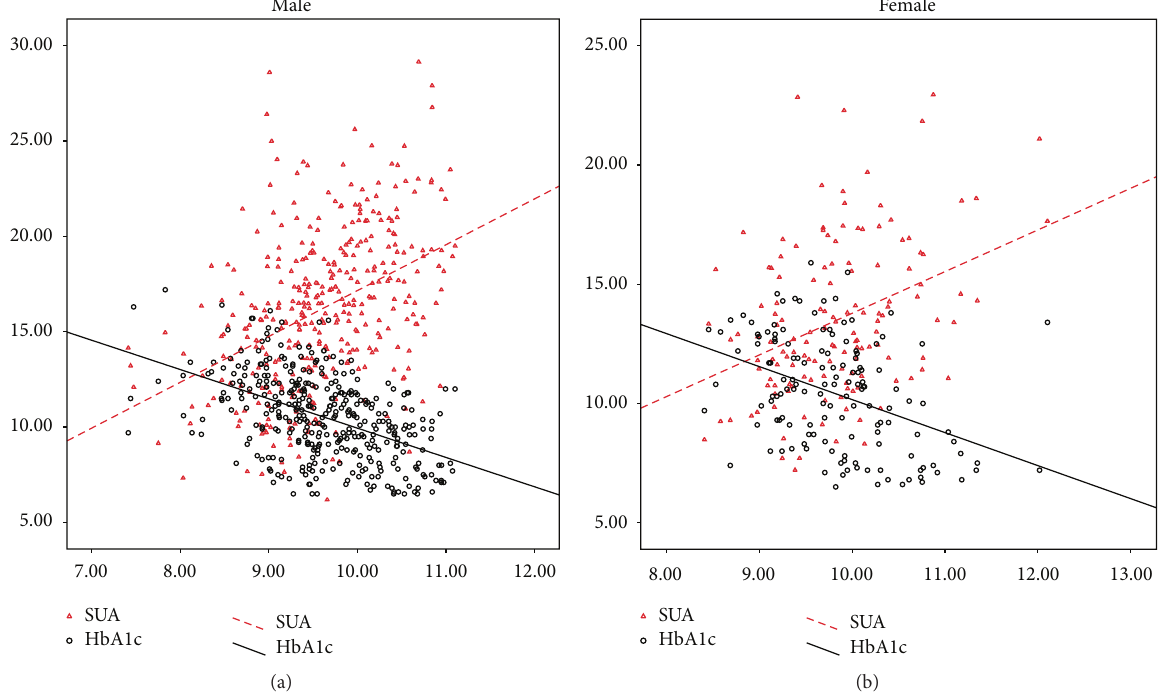
Figure 1: Scatter plots of the correlation between InsAUC120 and SUA as well as HbA1c in different genders. The abscissa is the area under the curve of insulin (InsAUC120). Both uric acid and HbA1c change with the increase in InsAUC120. However, the trends of the two correlation curves are opposite, in either male or female. Serum uric acid is directly correlated with insulin level, and HbA1c is inversely associated with insulin level.